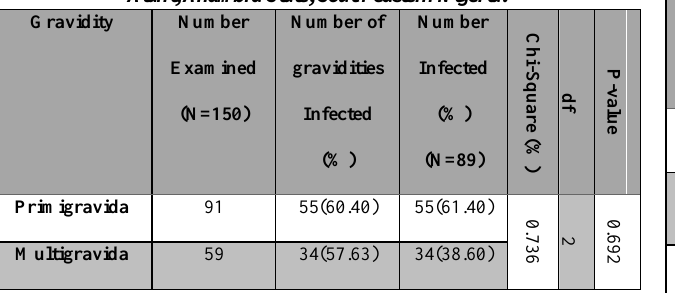
Table 2. Prevalence of malaria in conjunction with gravidity among gravid women attending antenatal clinic at two Maternity Centres in Atani, Anambra State, South-eastern Nigeria.